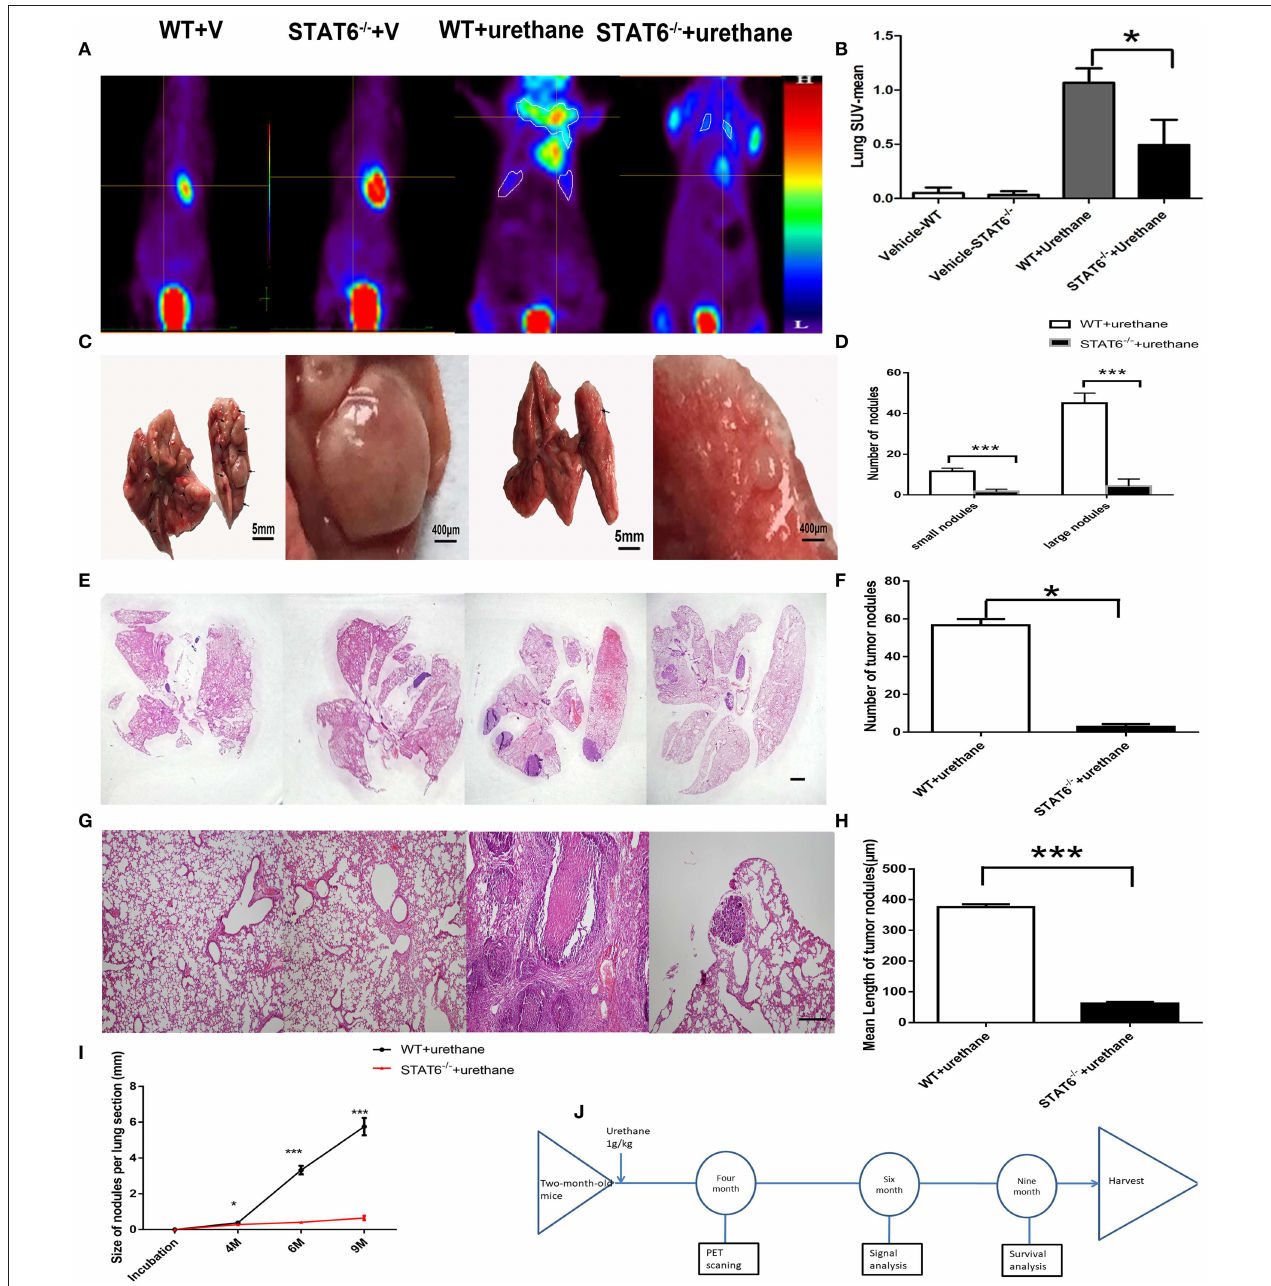
FIGURE 3 | Effect of signal transducer and activator of transcription 6 (STAT6) deficiency on primary tumor growth. (A–H) Show results at 6 months after urethane inoculation. (A,B) Representative images and quantitative analysis of lung nodules of STAT6 − / − mice or WT littermates detected by PET/MR at the time point of 4 months after inoculation of urethane. Urethane was intraperitoneally injected at 1 g/kg. (C) Facade of the lung from two groups; the two images on the left show WT tumor-bearing mice and the images on the right show STAT6 − / − tumor-bearing mice. (D) Number of small ( < 300 µ m) and large nodules (more than 300 µ m). (E) Hematoxylin and eosin (H&E) staining of overall lung sections. The bar represents 5mm. The four images have the same magnification. From left to right: WT + V, STAT6 − / − + V, WT + urethane, STAT6 − / − + urethane. (F) Quantification of lung nodules. (G) H&E-stained lung sections. The bar represents 2mm. The four images have the same magnification. From left to right: WT + V, STAT6 − / − + V, WT + urethane, STAT6 − / − + urethane. (H) Quantification of mean length in the lung section. (I) Size of tumor nodules at 4, 6, and 9 months. WT + V: WT mice with PBS (vehicle) inoculation; STAT6 − / − + V: STAT6 knockout mice with PBS (vehicle) inoculation. WT + urethane: WT mice with urethane inoculation; STAT6 − / − + urethane: STAT6 knockout mice with urethane inoculation. (J) The timeline of this experiment. Briefly, 2-month-old mice were induced with primary carcinogen by urethane (1 g/kg), then were harvested for biochemistry analysis 6 months later of urethane, and part of mice were kept to 9 months for survival analysis. All mice were harvested at 9 months later of urethane. Data are presented as mean ± SD of one representative experiment. Similar results were obtained in three independent experiments. Unpaired Student’s t -tests were used unless noted otherwise. * P < 0.05, *** P < 0.001.